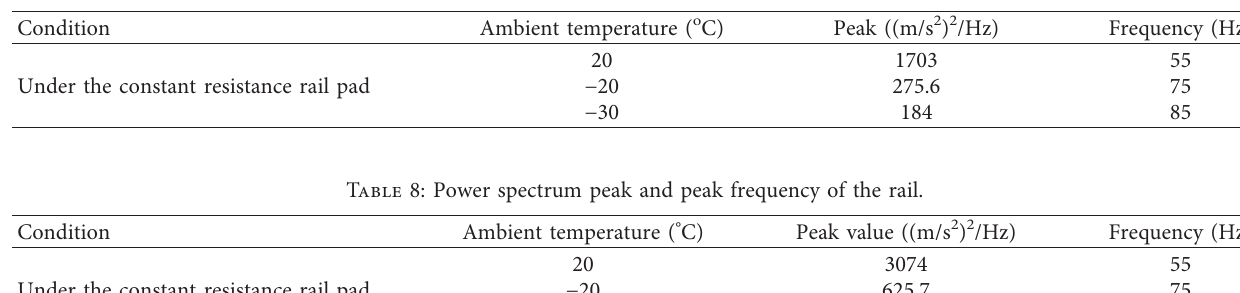
Figure 18: Power spectrum of temperature/frequency variable wheelset and rail acceleration of elastic cushion pad with constant resistance: (a) wheelset; (b) rail. Table 7: Wheelset power spectrum peak and peak frequency.